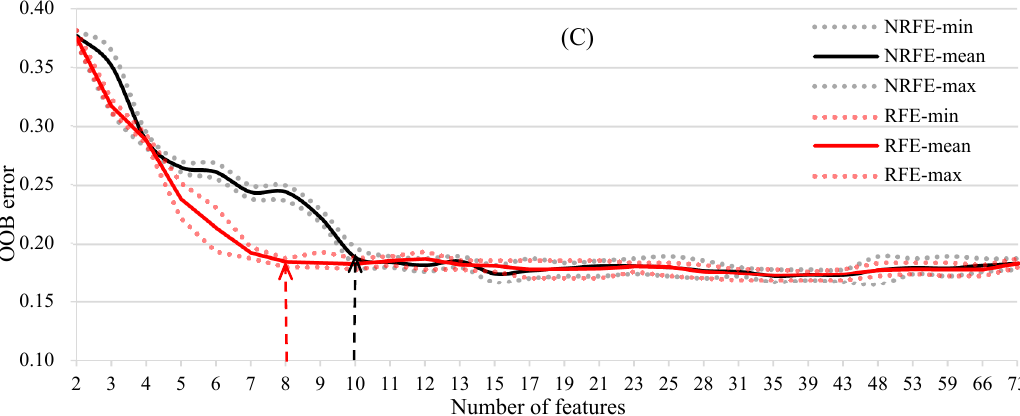
Figure 4. The out-of-bag (OOB) error estimate versus the number of features used for RFE and NRFE algorithms based on 20 runs: ( A ) Landsat 8; ( B ) Sentinel-2; and ( C ) Pléiades-1.